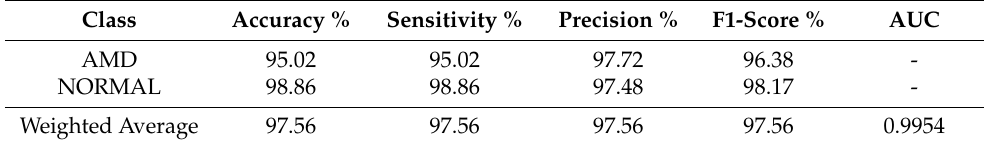
Table 5. Quantitative results on the Duke test set.